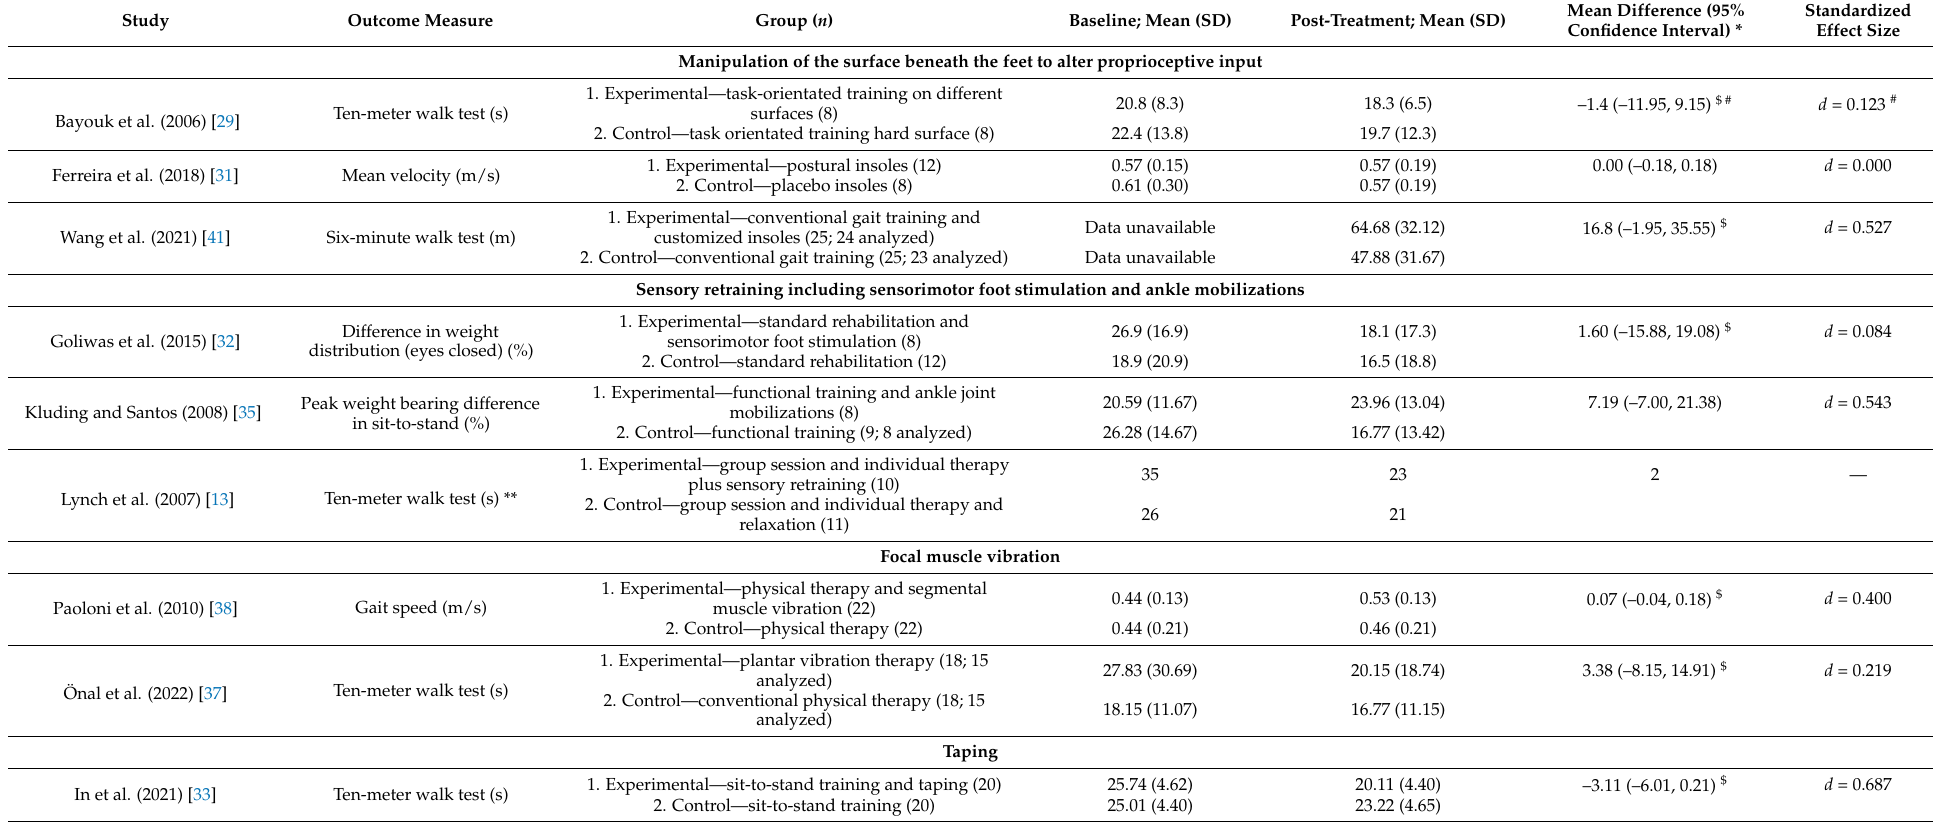
Table 4. Estimates of treatment effect and standardized effect